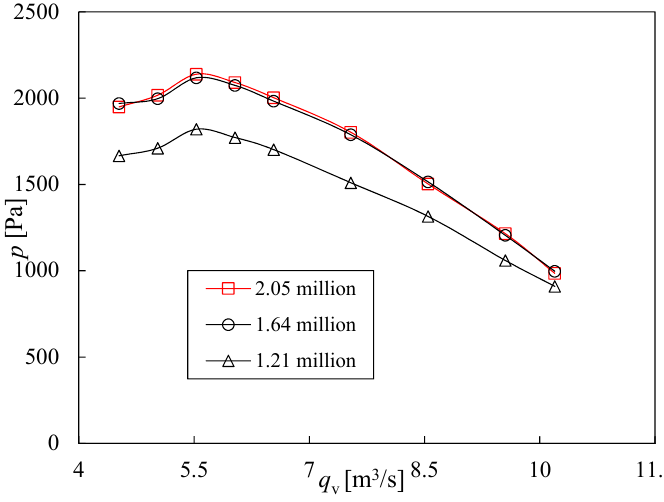
Figure 4. Computation test of grid uncertainty.